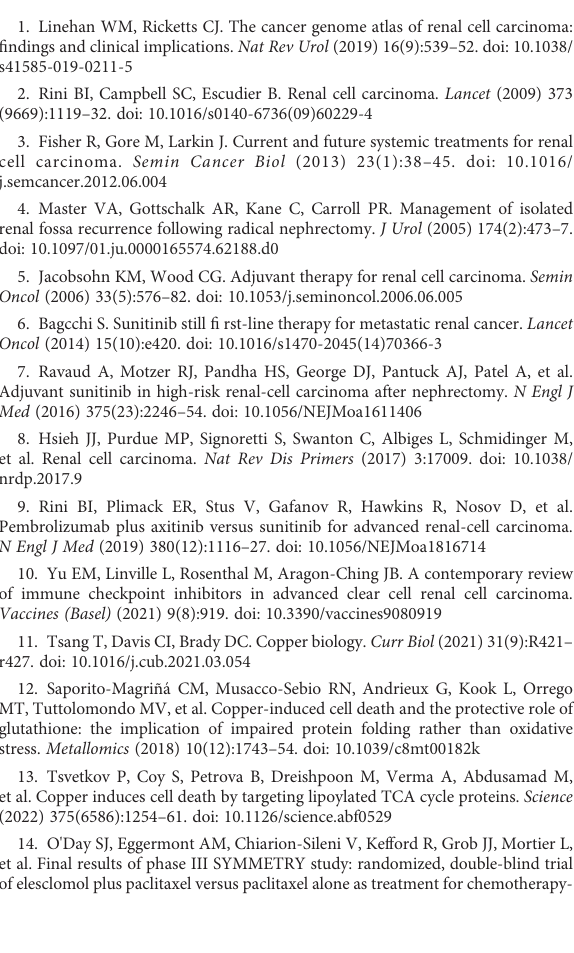
SUPPLEMENTARY FIGURE 6 Observation of the sensitivity of CPGs to targeted drugs using the GSCA database. (A) Correlation between GDSC drug sensitivity and CPGs mRNA expression. (B) Correlation between CTRP drug sensitivity and CPGs mRNA expression. CPG, cuproptosis-promoting